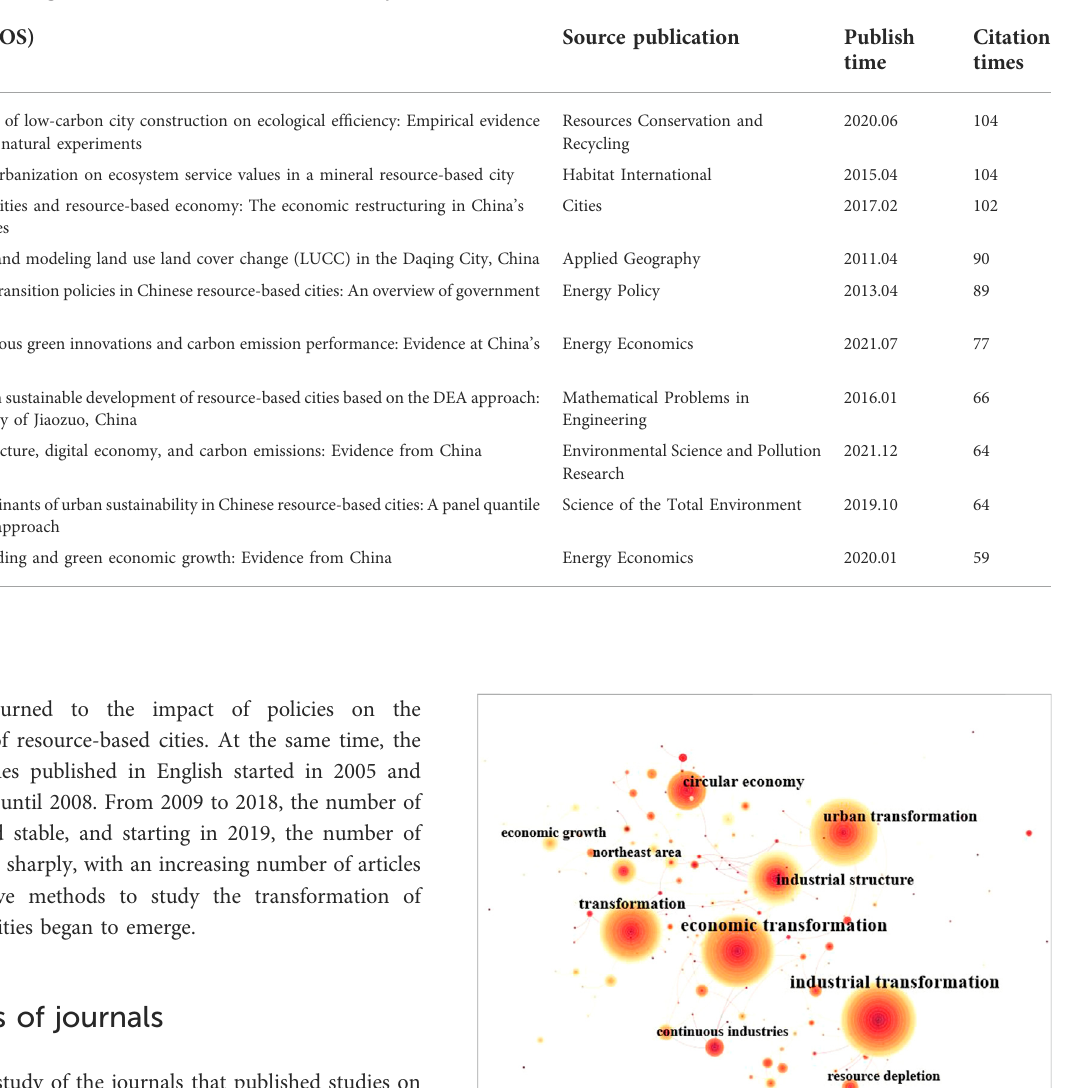
TABLE 4 Highly cited English studies on resource-based cities (top 10).